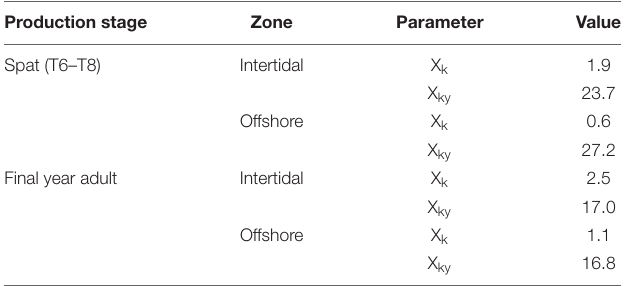
TABLE 4 | Calibrated half-saturation coefficients (X k , X ky ) used in MERIS-driven DEB modeling of Pacific oyster spat and adult growth, and applied to all nine modeled years.